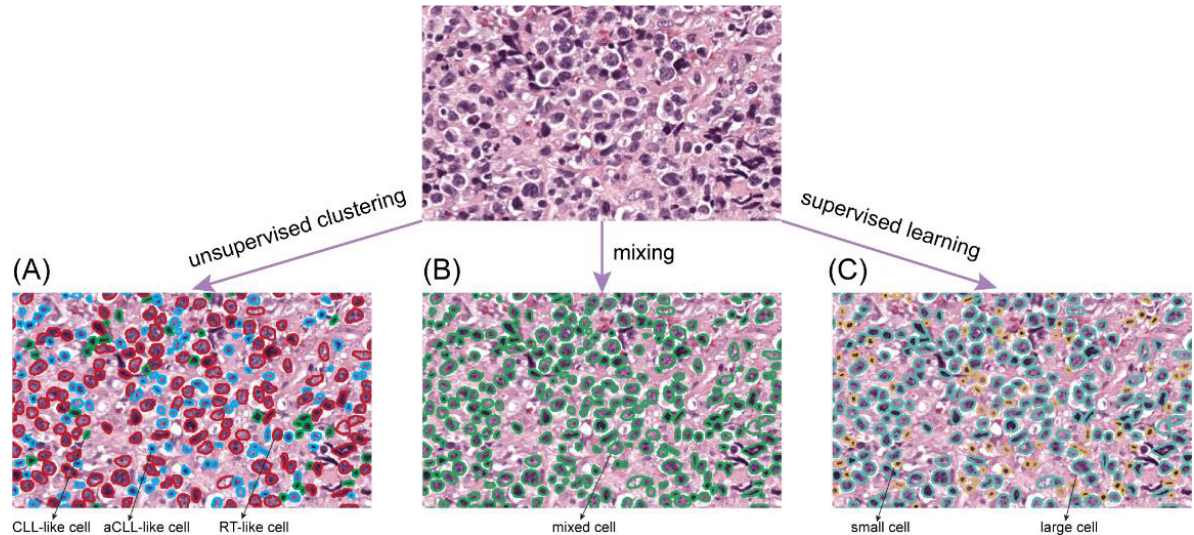
Figure 2. Comparison of three approaches to assess cells: ( A ) Unsupervised learning clusters cells into three categories (CLL-like, aCLL-like, and RT-like). ( B ) Mixing the cells without distinguishing them. ( C ) Supervised learning separates cells into small/large categories. Table 2. Cellular features extracted from unsupervised clustering, mixing, and supervised learning, and termed unsupervised features, mixed features, and supervised features, respectively. Unsupervised Features